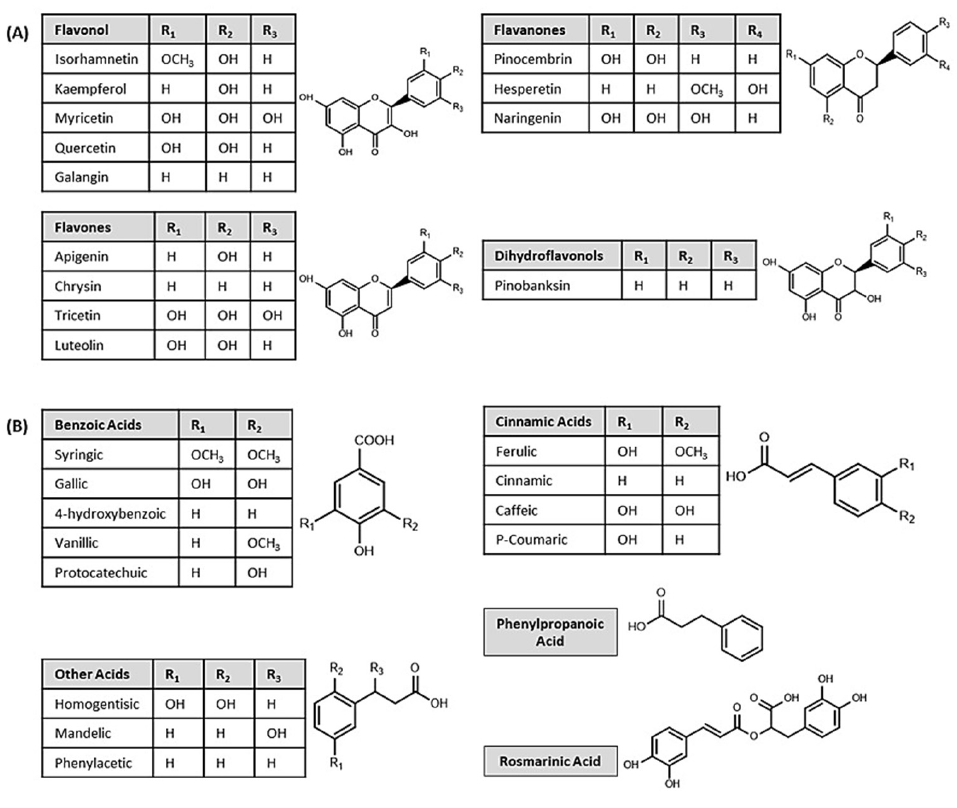
Figure 3. Chemical structures of some important phenolic components in honey; ( A ) flavonoids and ( B ) phenolic acids.